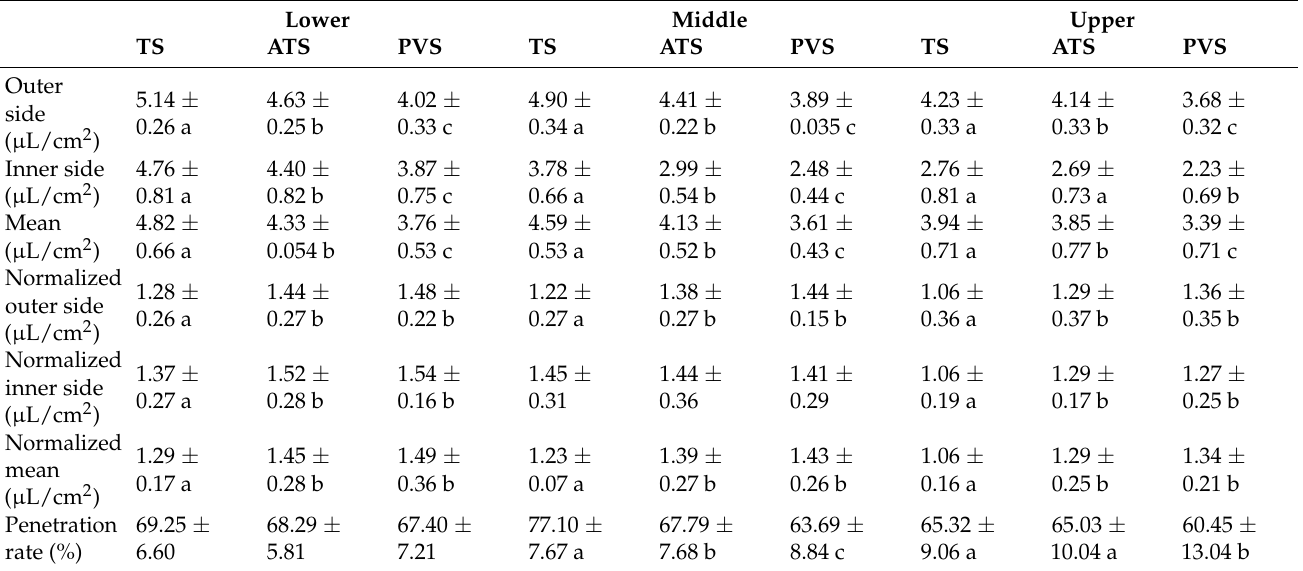
Table 5. Parameters of DD at different sample locations evaluated in the test. The data in the table were obtained through SPSS. SEM was used to represent the deviation of the data in the table. Lower Middle Upper